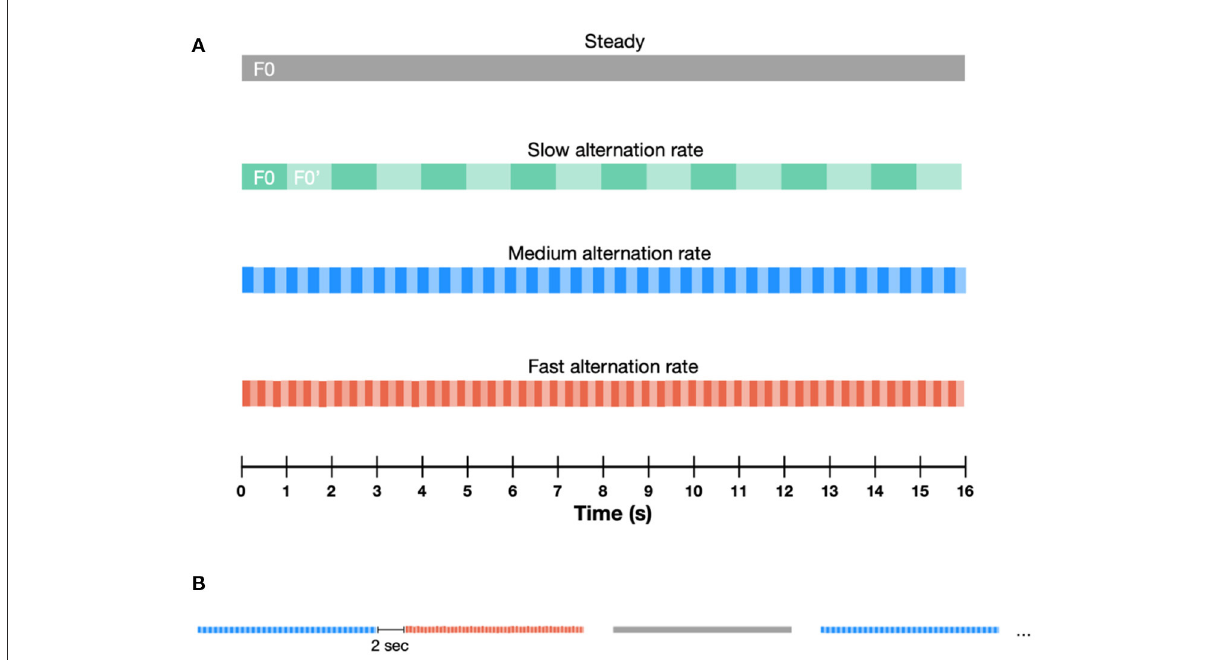
FIGURE1 Schematic illustration of the paradigm containing different types of auditory sequences. (A) The F0 of these sequences was either steady or alternating between F0 and F0 ′ , throughout the sequence. Three alternation rates were presented: slow (1Hz), medium (2.5Hz) and fast (6.5Hz). (B) Sequence duration was fixed at 16s. Sequences were separated by 2 s-long